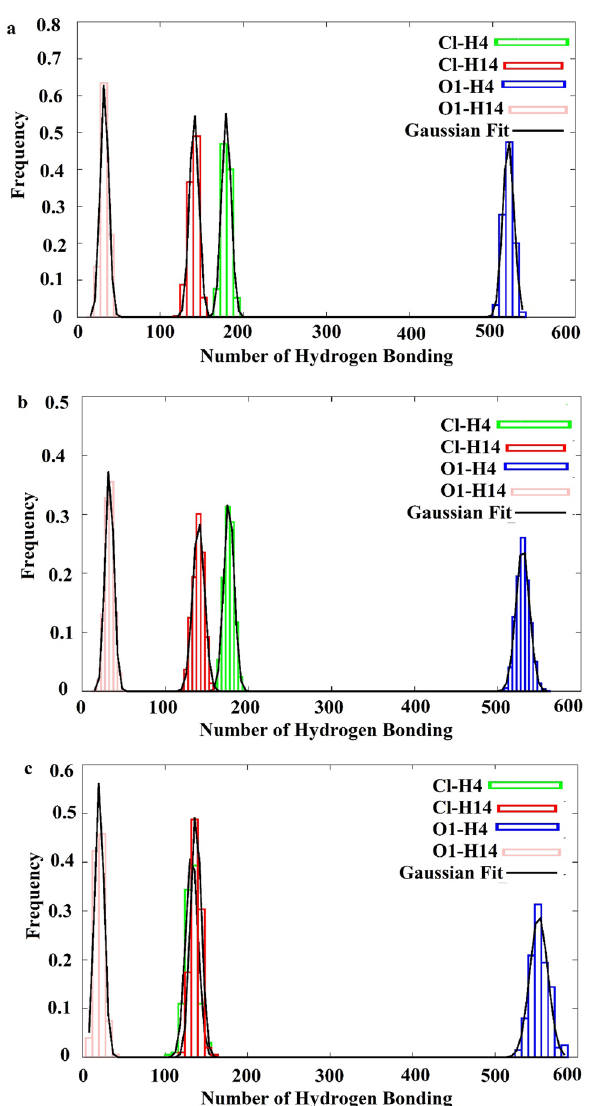
Figure 4. The normalized-distribution of average number of hydrogen bond between species at ( a ) 293 K, ( b ) 321 K and ( c ) 400 K were prepared using Gnuplot 5.2.6 softwre ((http:// www. gnupl ot. info/). The data were fitted using Gnuplot 5.2.6 (http:// www. gnupl ot.